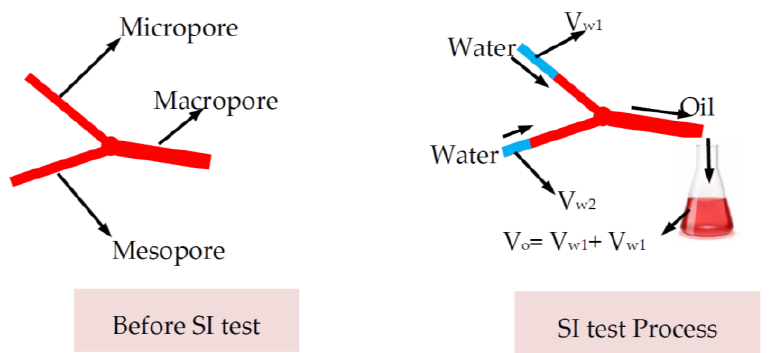
Figure 7. Schematic diagram for oil and water migration in pores.